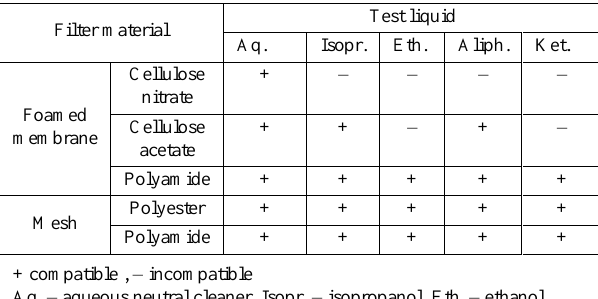
Table 2. Filters types and their compatibility with test liquids